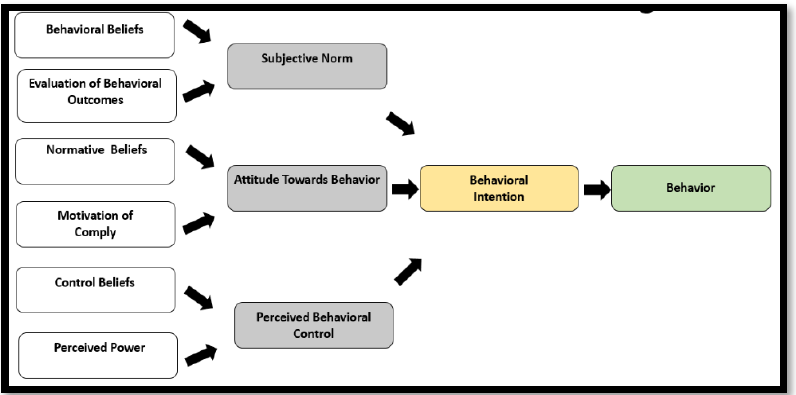
Figure 1. Theoretical Model of the CoMIC trial, based on the Theory of Reasoned Action (TRA) and the Theory of Planned Behavior (TPB).